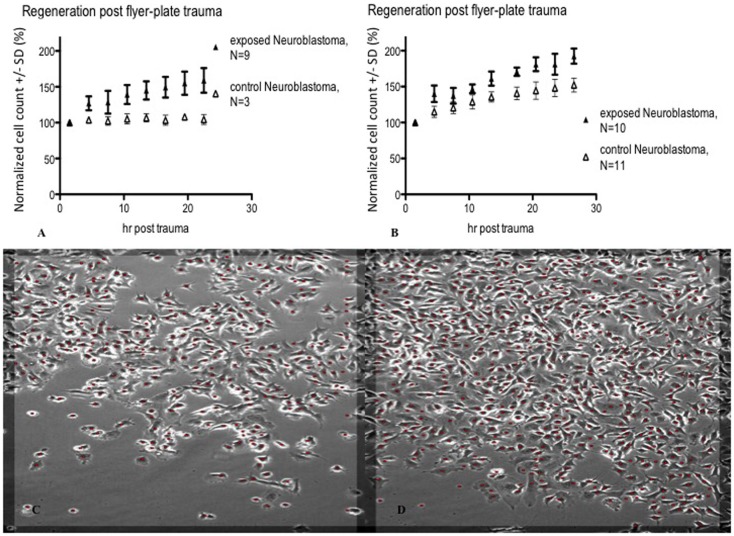
Cell count (normalized mean ± SD) in lesion peripheries vs. control-colonies of neuroblastoma. Trauma exposures in two different sets of measurements (A,B) are shown. Micrographs of live neuroblastoma – first (C) and last (D) images post trauma – illustrating growth at the lesion periphery. The red dots indicate counted cells. Original magnification 10×. Incubated, photographed, and counted by Cell-IQ.